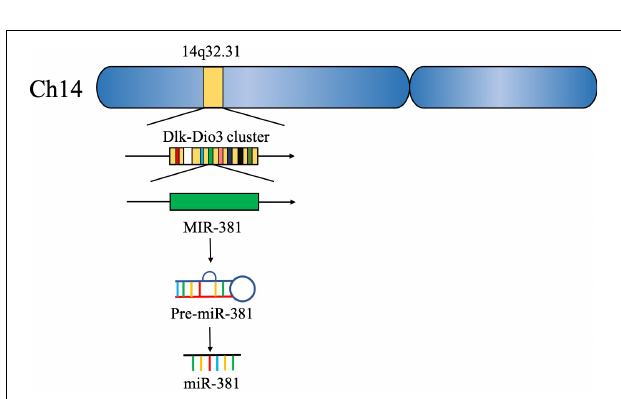
FIGURE 2 | miR-381 belongs to the 14q32.31 gene